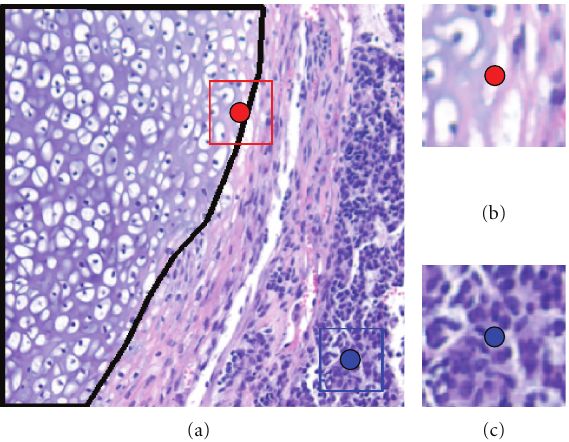
Figure 2: Examples of Boundary Type Pixel and Interior Type Pixel. (a) Original image with two pixels marked. (b) Magnified window of boundary-type pixel. (c) Magnified window of interior- type pixel. Black line indicates boundary between tissue